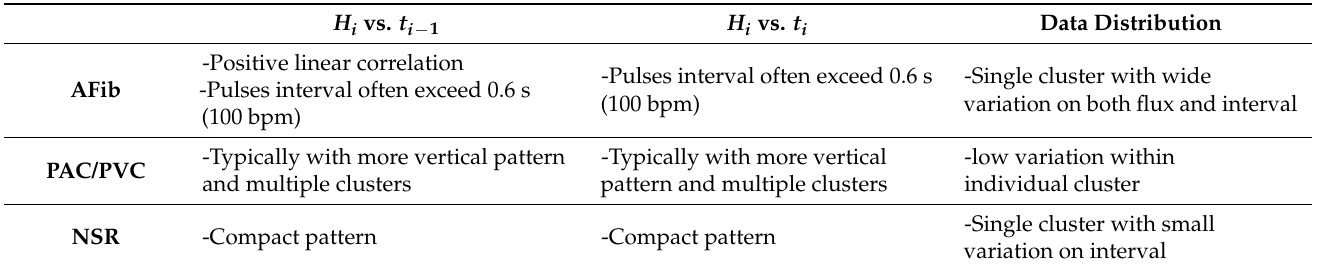
Table 2. Distinct flux-interval plot characteristics for visual